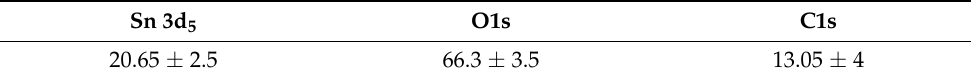
Table 3. Atomic concentrations (%) of SnO 2 pixels transferred by LIFT at 100 mJ/cm 2 .